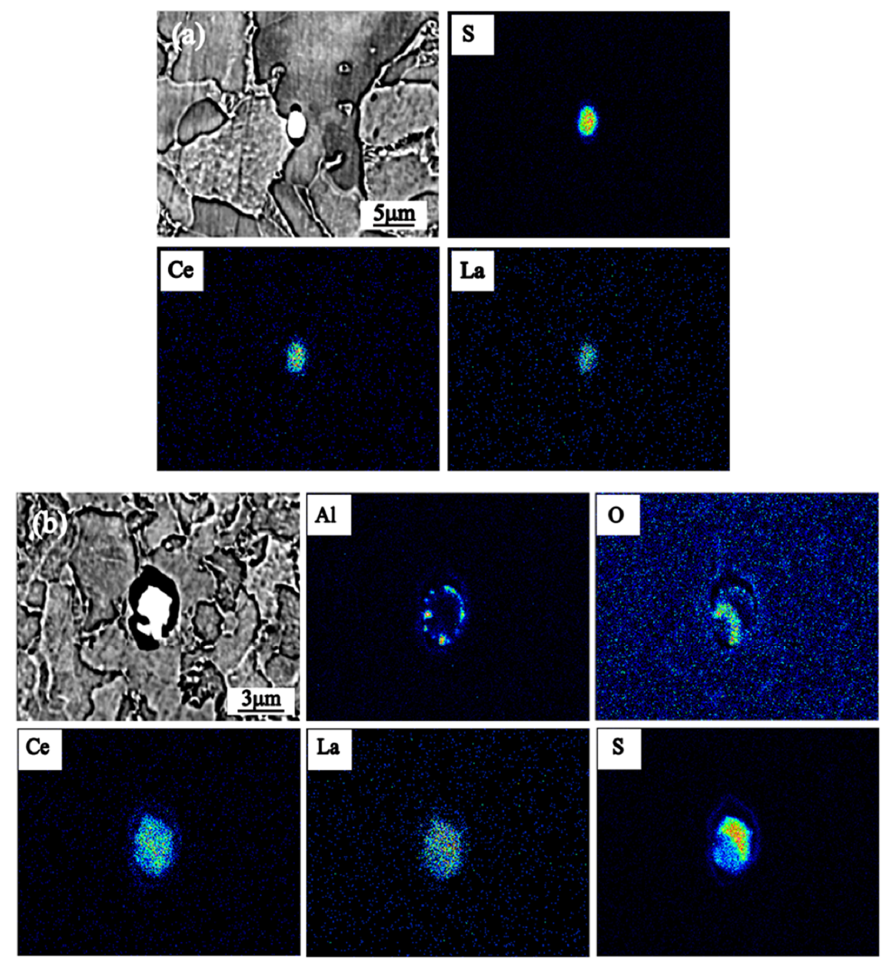
Figure 11. SEM images and EPMA mapping of inclusions in RE-modified ( a ) Q235BM ( b ) Q355BM.